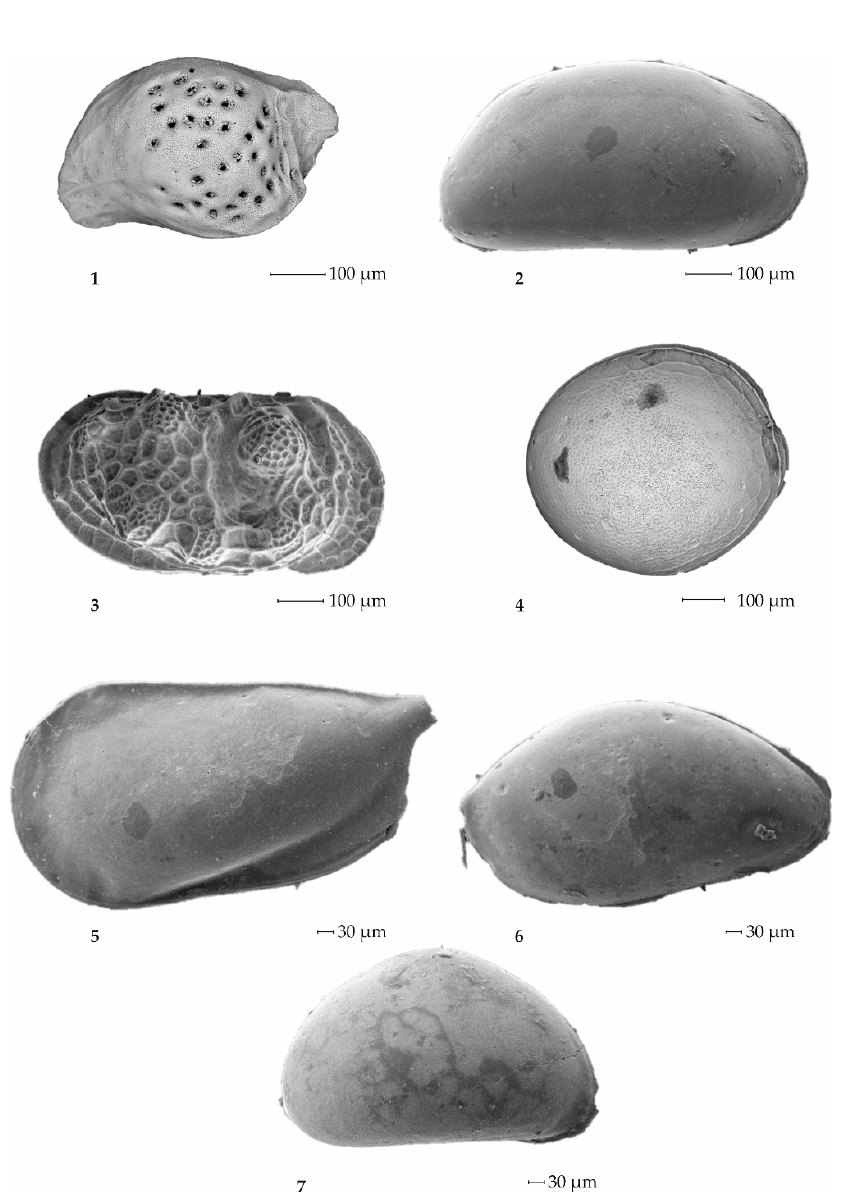
Figure A2. 1— Kangarina sp. Lateral exterior view, left valve; 2— Krithe ( Austrokrithe ) magna . Lateral exterior view, right valve; 3— Nodoconcha minuta . Lateral exterior view, right valve; 4— Polycope sp. Lateral exterior view, left valve; 5— Pseudocythere aff. P . caudata . Lateral exterior view, left valve; 6— Paradoxostoma hypselum . Lateral exterior view, right valve; 7— Xestoleberis rigusa . Lateral exterior view, right valve.